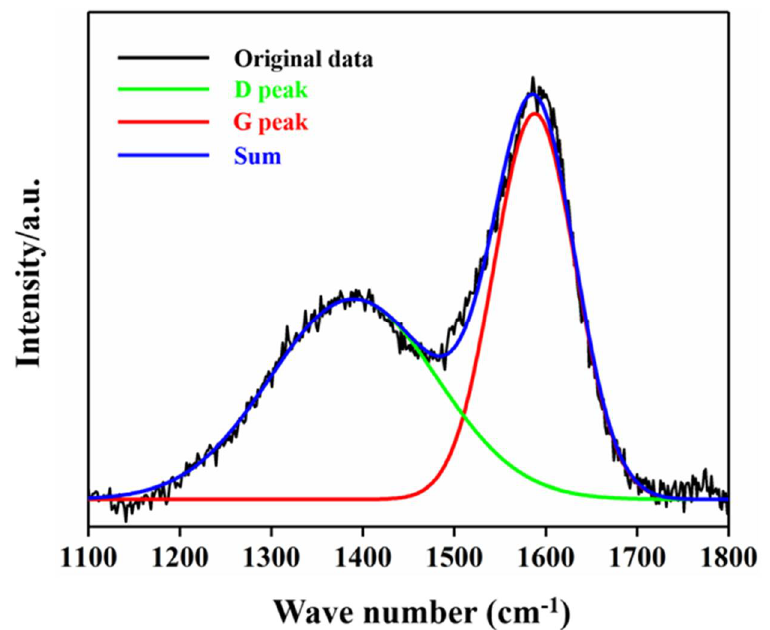
Figure 3. Raman pattern of Ni − DLC/TNT electrode surface.